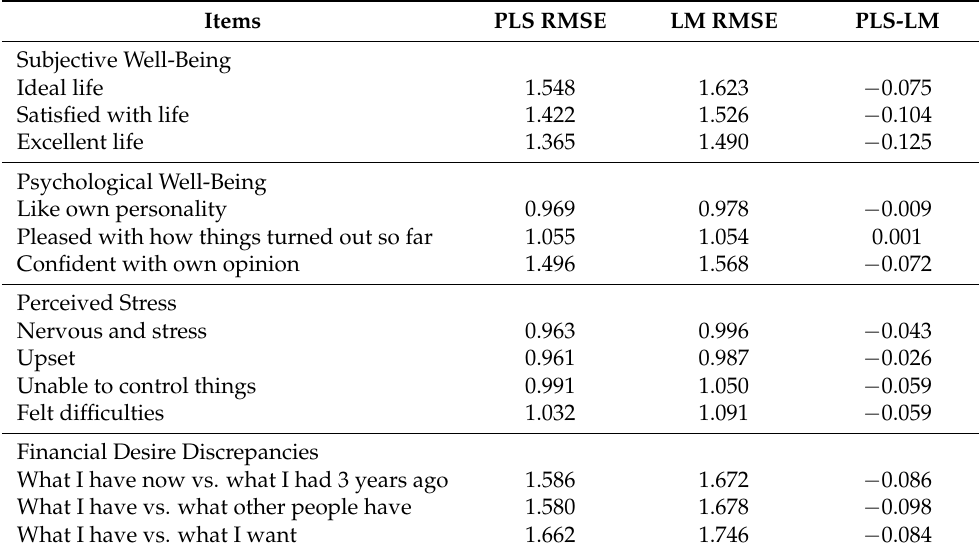
Table 8. PLS Predict (Structural Model Built vs. Linear Model).